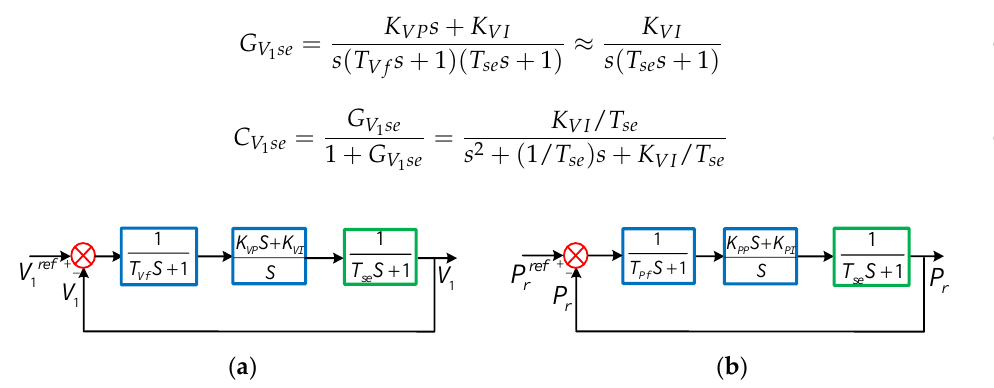
Figure 17. Diagrams of the unity-feedback control loops including the feedforward blocks of the series converter. ( a ) The voltage control loop including the feedforward blocks related to v 12 d ; ( b ) The active power control loops including the feedforward blocks related to v 12 q ;